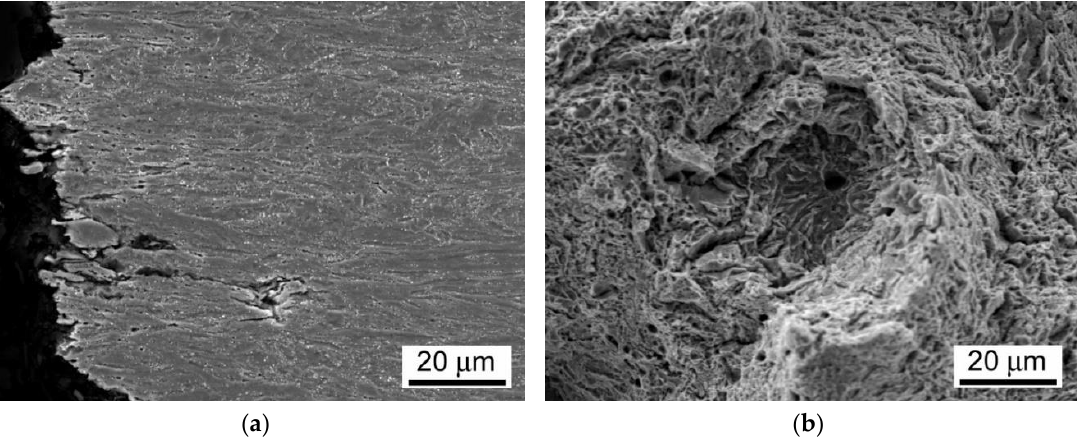
Figure 14. Fracture analysis of hydrogen-charged T92/T92 weldment initially processed by the PWHT-1 and subsequently ruptured in SC-HAZ after the room-temperature tensile test: ( a ) fracture path and microstructure beneath the fracture; ( b ) fracture surface showing mixed fracture consisting of both transgranular quasi-cleavage with a “fish-eye” morphology and ductile dimple tearing.